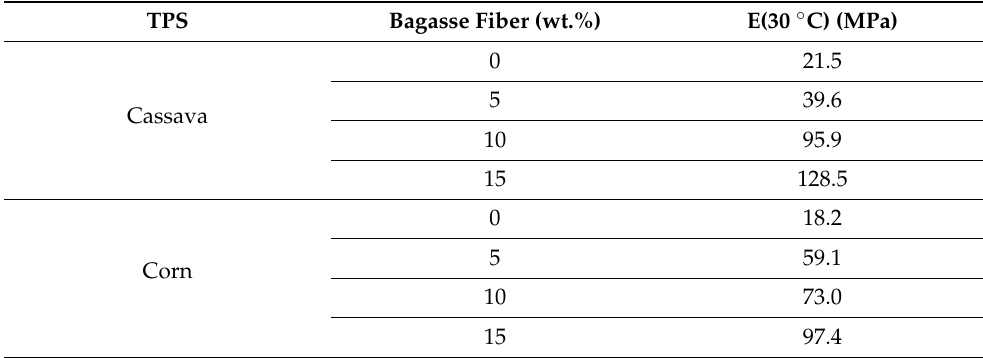
Table 12. Dynamic-mechanical properties of cassava and corn thermoplastic starch and their compos- ites [147]. TPS Bagasse Fiber